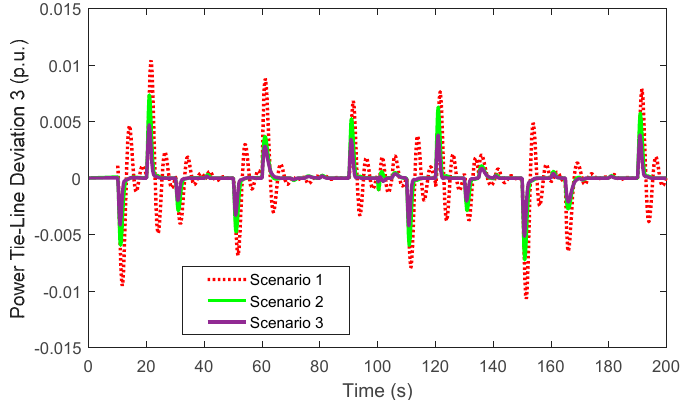
Figure 16. Comparison of the exchange tie-line power deviations between microgrids 3 and 1 in the three scenarios.